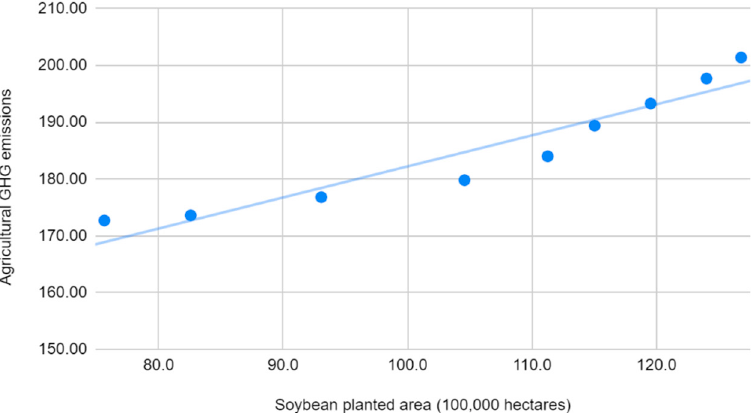
Figure 15. Correlation chart: agricultural GHG emissions and soybean planted area. Prepared by the authors.